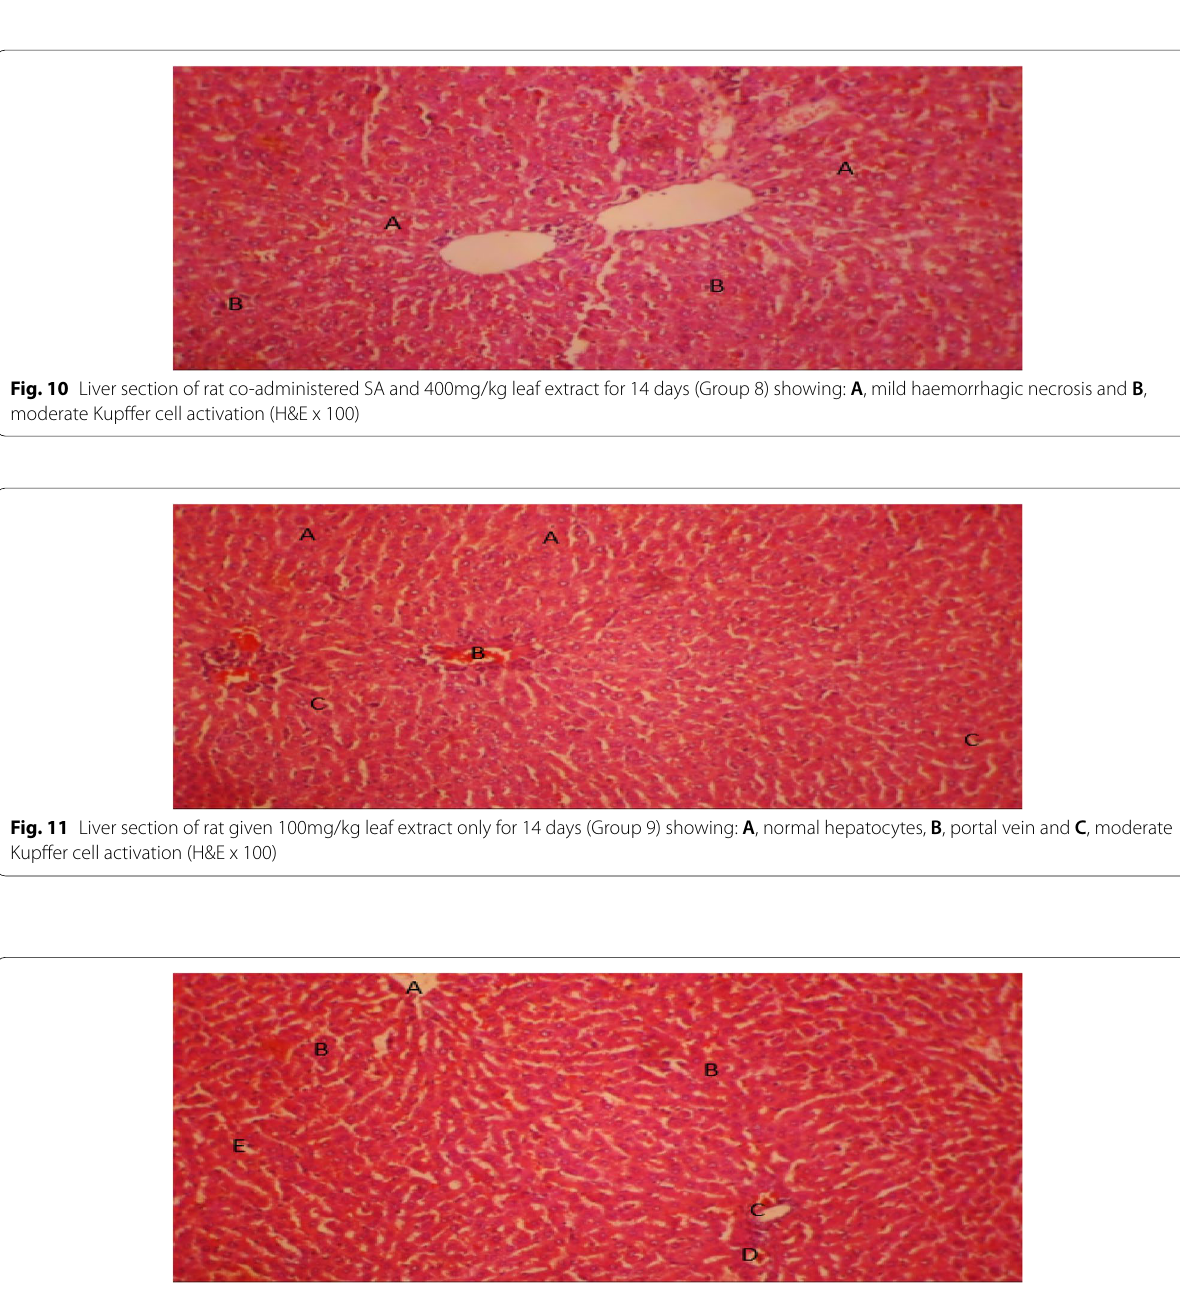
Fig. 12 Liver section of rat given 200mg/kg leaf extract only for 14 days (Group 10) showing: A , central vein, B , normal hepatocytes, C , bile duct, D , portal vein and E , mild Kupffer cell activation (H&E x